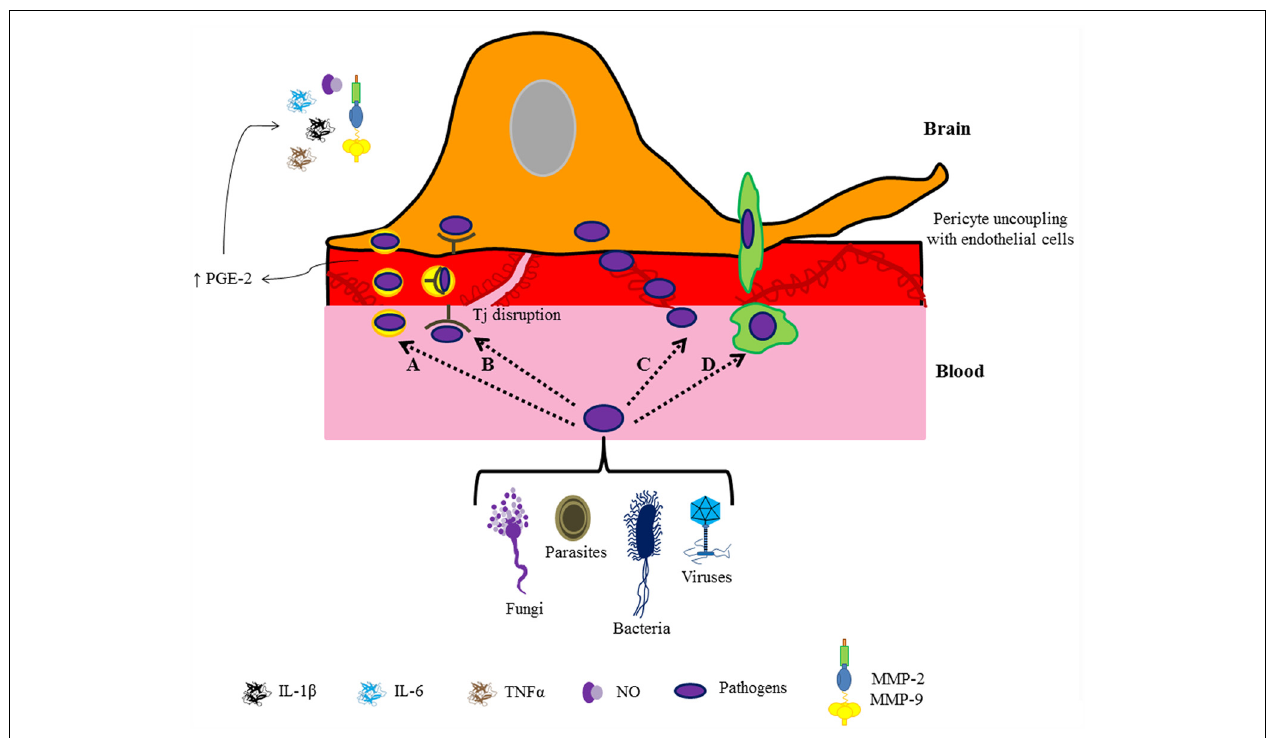
FIGURE 2 | Pathogen entry to the brain. The cartoon depicts different routes for pathogen entry to the brain: caveolae (A) , receptor-mediated transport (B) , paracellular diffusion (C) , and transmigration through infected leukocytes (D) . In all cases a pericyte-mediated immune response followed by blood–brain barrier breakdown is